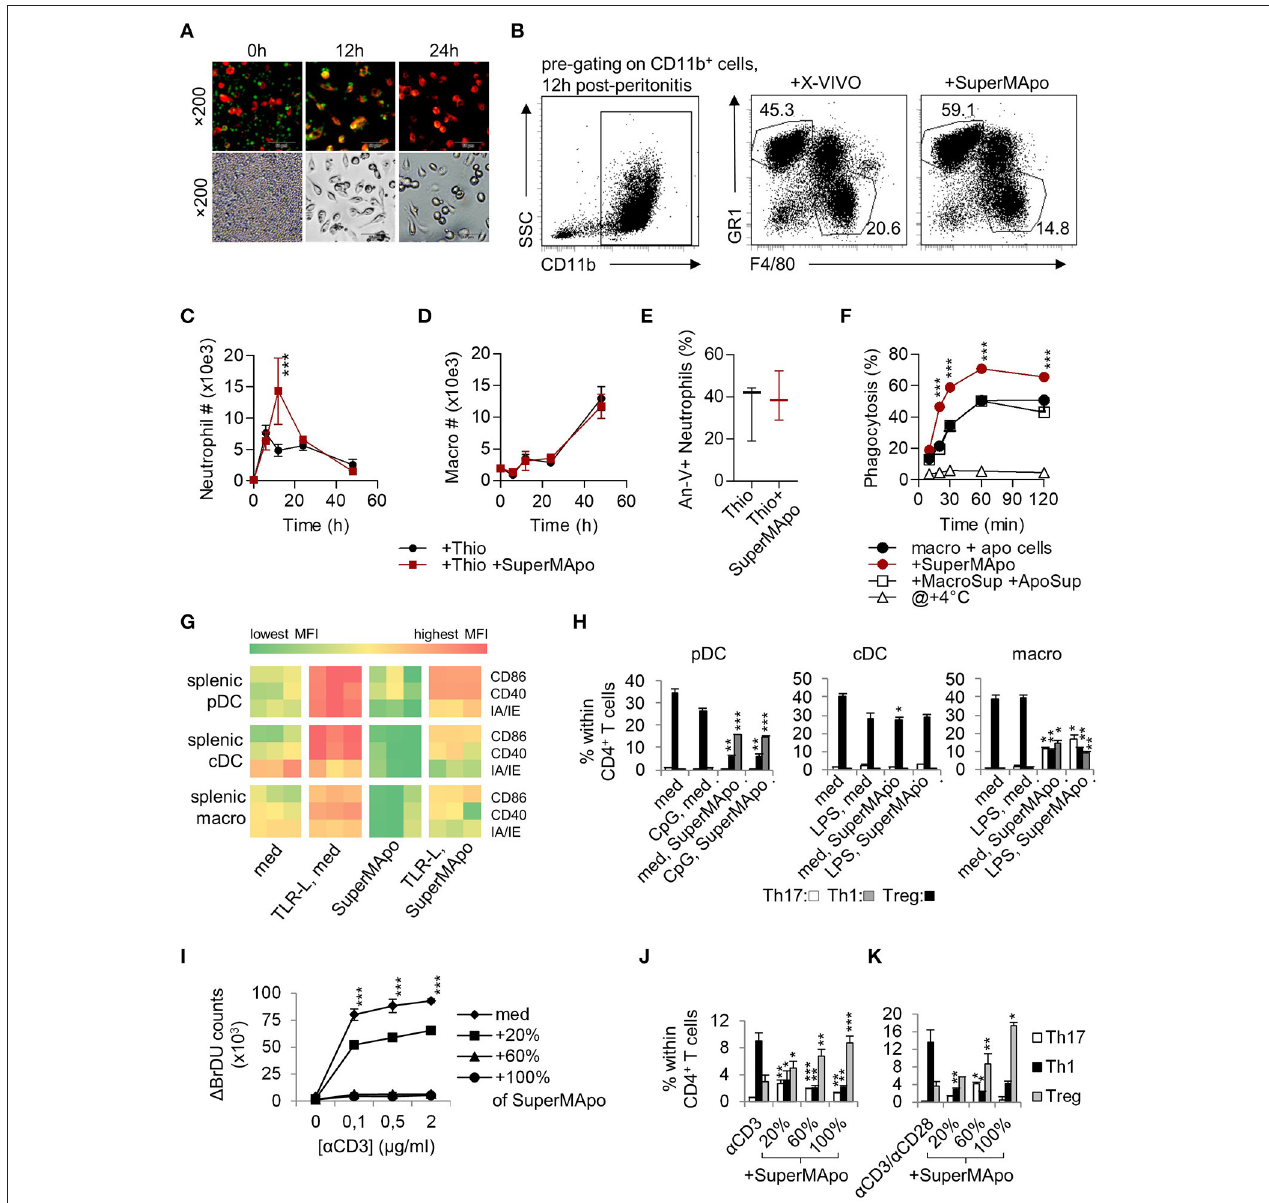
FIGURE 1 | Macrophages eliminating apoptotic cells produced factors with pro-resolutive properties. (A) Inverted fluorescence microscopy observation of macrophages stained by PE-F4/80 antibody (red), eliminating CFSE-labeled apoptotic cells (green) at 0, 12, and 24h of culture. Injection (i.p.) of the supernatant from the previous 48h culture (SuperMApo) increased neutrophil percentage (B) and number (C) , not macrophage number (D) in the peritoneal cavity after peritonitis induction. (E) Neutrophil apoptosis 24h after peritonitis induction in the presence or not of SuperMApo injection 28h earlier ( n = 3 mice per group; box and whiskers). The gating strategy of peritoneal neutrophils and macrophages is shown in (B) , other data are shown as mean ± s.e.m., n = 3. *** P < 0.001, two-way RM ANOVA with Bonferroni post-tests. (F) The percentage of phagocytosis (mean ± s.e.m., n = 3) of apoptotic cells by macrophages was evaluated at various time points in normal culture condition (macro + apo cells) with or without SuperMApo or supernatant from macrophages cultured alone plus the supernatant from apoptotic cells cultured alone ( + MacroSup + ApoSup), or at + 4 ◦ C. *** P < 0.001, two-way RM ANOVA with Bonferroni post-tests. (G) Costimulatory (CD86/CD40) and MHC-II molecule (IA/IE) mean florescence intensity (MFI) expressions evaluated in plasmacytoid DC (pDC), conventional DC (cDC) and macrophages (macro) in spleen cell cultures with or without TLR ligands (TLR-L) or SuperMApo, or medium (med). Each cell in the heat map represents a single well; data are from one experiment representative of three. ( H ) Ovalbumin (OVA) TCR-specific CD4 + CD25 − T cell polarization (mean ± s.e.m., n = .3) by pDC, cDC and macrophages cultured as in G in the presence of OVA, was assessed by FACS evaluating IFN- γ (Th1), IL-17 (Th17) and Foxp3 (Treg) intracellular content after 4 days of culture. * P < 0.05, ** P < 0.01, *** P < 0.001, 1 way ANOVA with Bonferroni’s multiple comparison test. (I) Spleen T cell proliferation in the presence of grading doses of anti-CD3 specific antibody ( α CD3) with medium (med) or SuperMApo in different proportions was assessed by BrdU incorporation and counting. *** P < 0.001, med vs. other conditions (mean